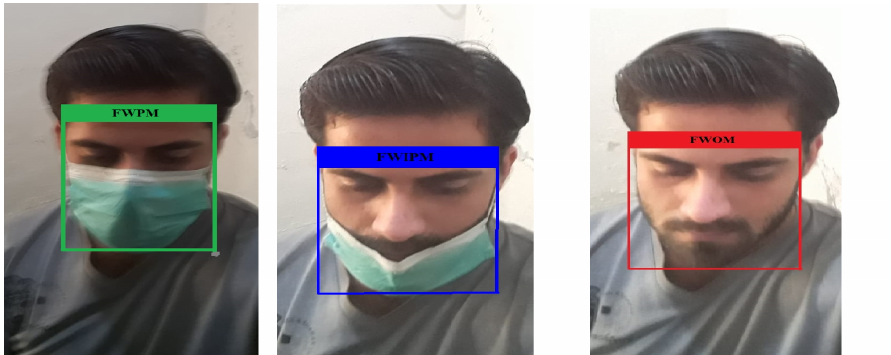
Figure 18. VGG-16 face mask detection classification results in real